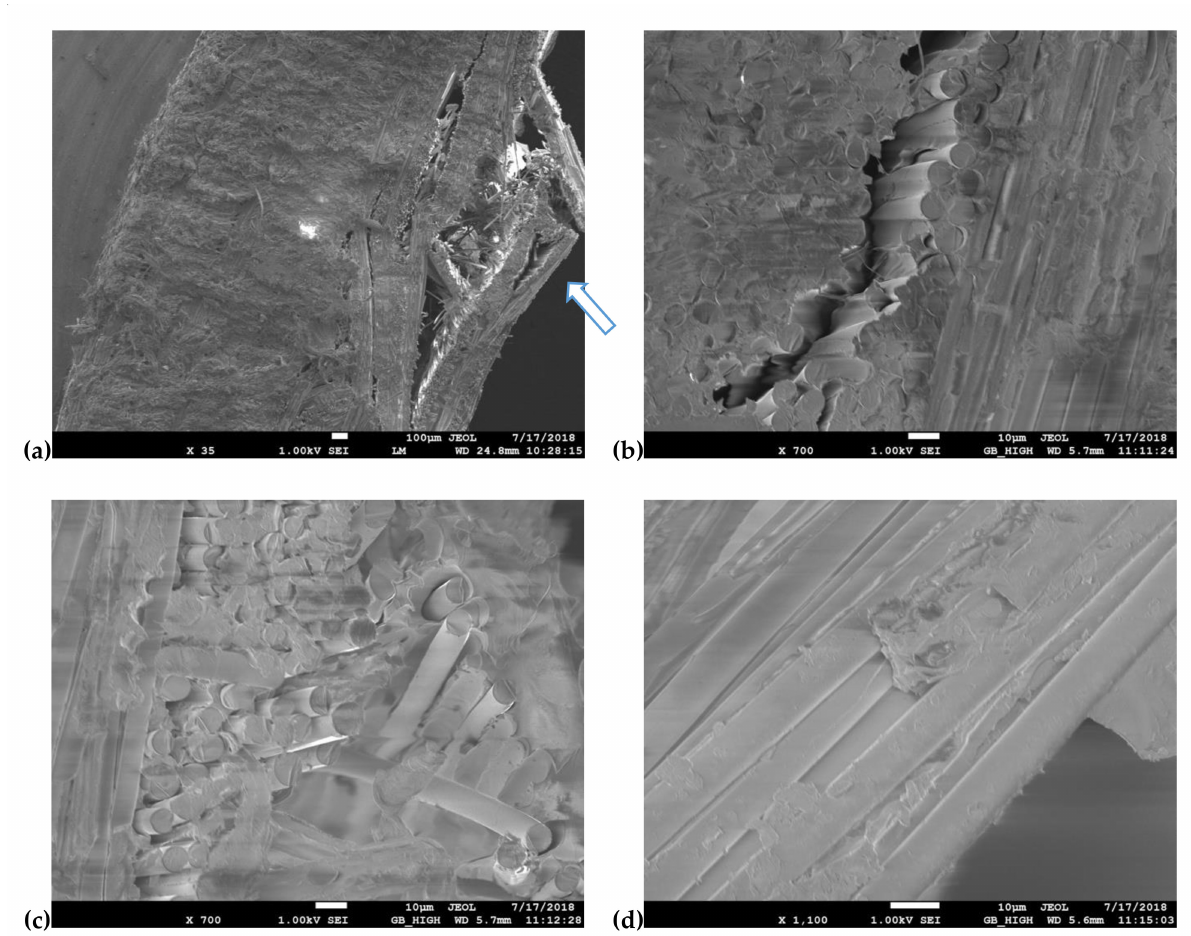
Figure 14. Scanning Electron microscopy from the fracture area of the Vectran/aluminum–glass composite hybrid three- point bending specimens (compressive side). ( a ) Compressive side, ( b ) delamination crack, ( c ) glass and aluminum fibers failure, ( d ) aluminum fibers exposed